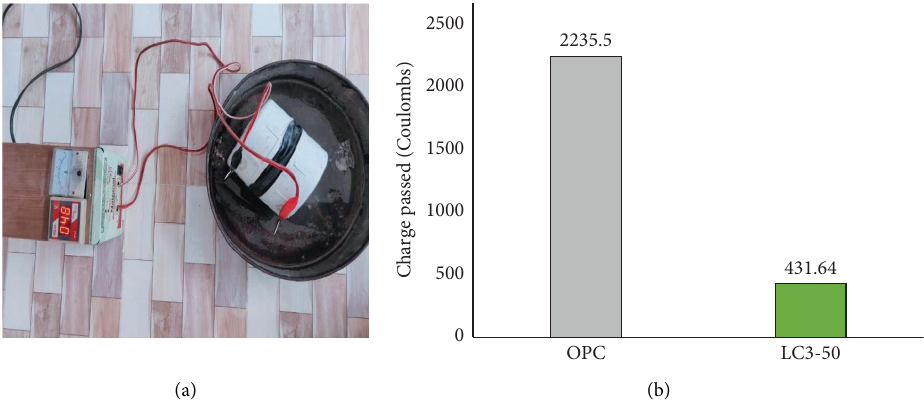
Figure 9: Results of the rapid chloride penetration test. (a) RCPT with 50mm thick slices of concrete. (b) RCPTshows LC 3 -50 performed better as compared to OPC.